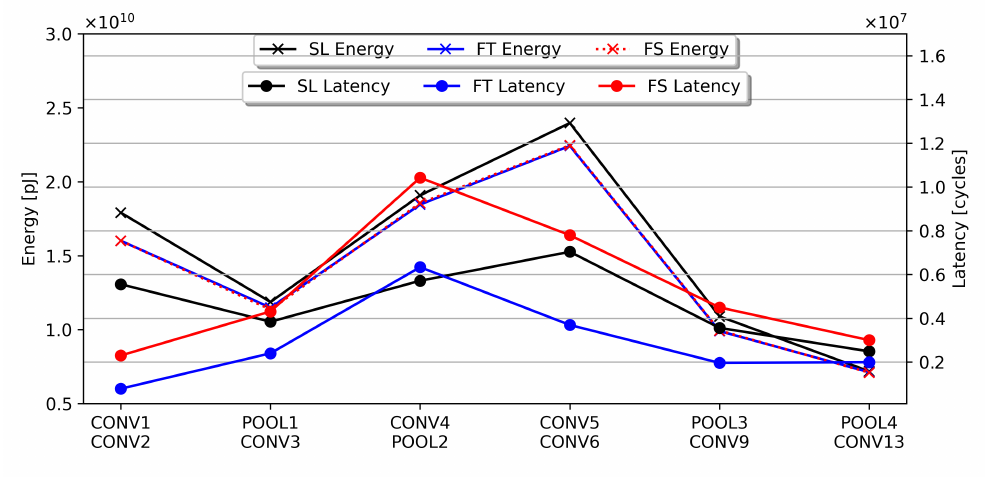
Figure 15. VGG16-E single layer (SL) vs. temporal fusion (FT) vs. spatial fusion (FS) with HW config.